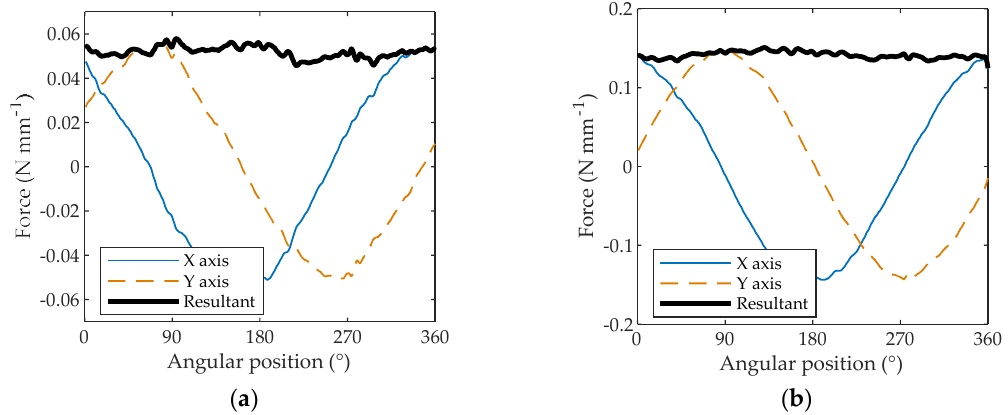
Figure 6. Resultant force on PTFE-machined up-milling with a depth of cut of: ( a ) 0.3 mm; ( b ) 1.5 mm.